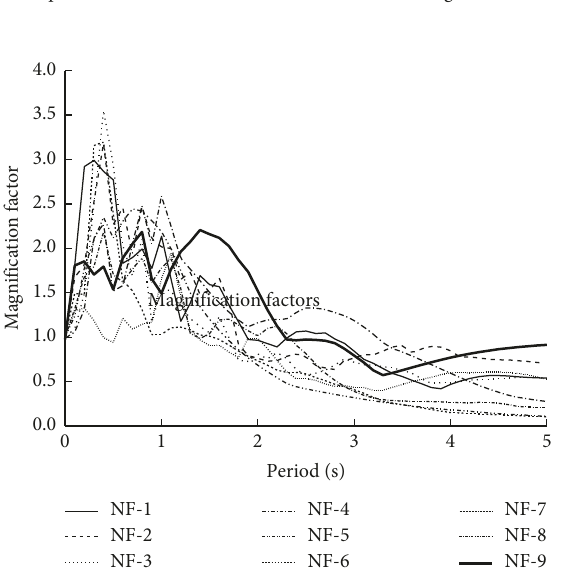
Figure 3: Response spectrum of near-fault ground